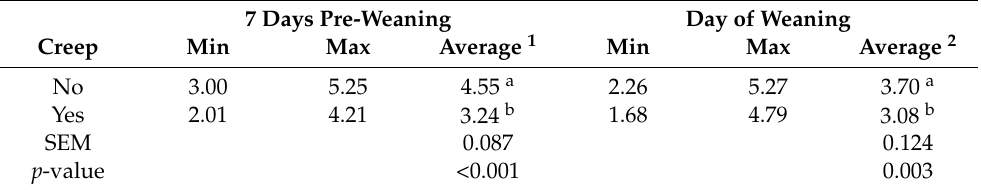
Table 3. Real-time stomach pH of piglets in response to creep feed during suckling and at weaning. 7 Days Pre-Weaning Day of Weaning